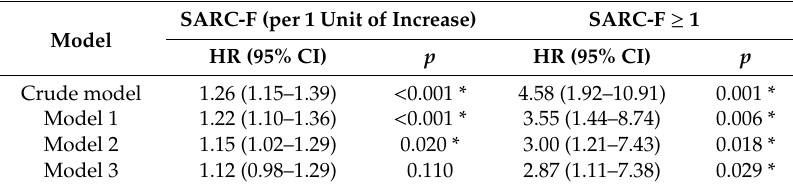
Model 1: adjusted for age and sex. Model 2: Adjusted for Model 1 plus cardiovascular disease, Charlson comorbidity index, and body mass index. Model 3: Adjusted for Model 2 plus Kt / V, albumin, creatinine, phosphorus, C-reactive protein, and nPNA. * p < 0.05 was considered statistically